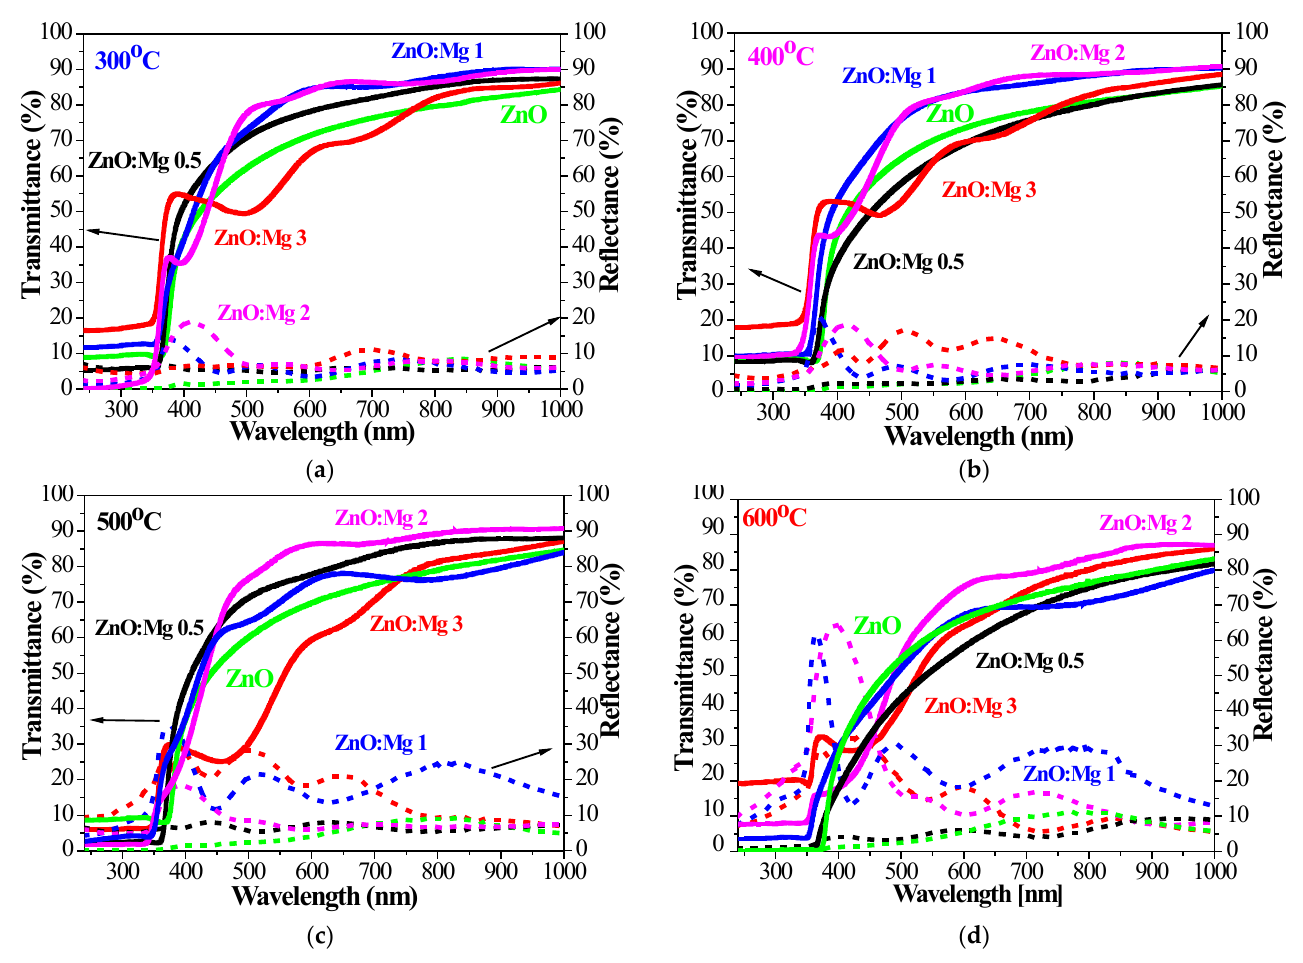
Figure 10. Comparison of the transmittance and reflectance spectra of sol–gel ZnO and ZnO:Mg films, treated at ( a ) 300, ( b ) 400, ( c ) 500 and ( d ) 600 °C. Transmittance of the bare quartz substrate is given as a reference.